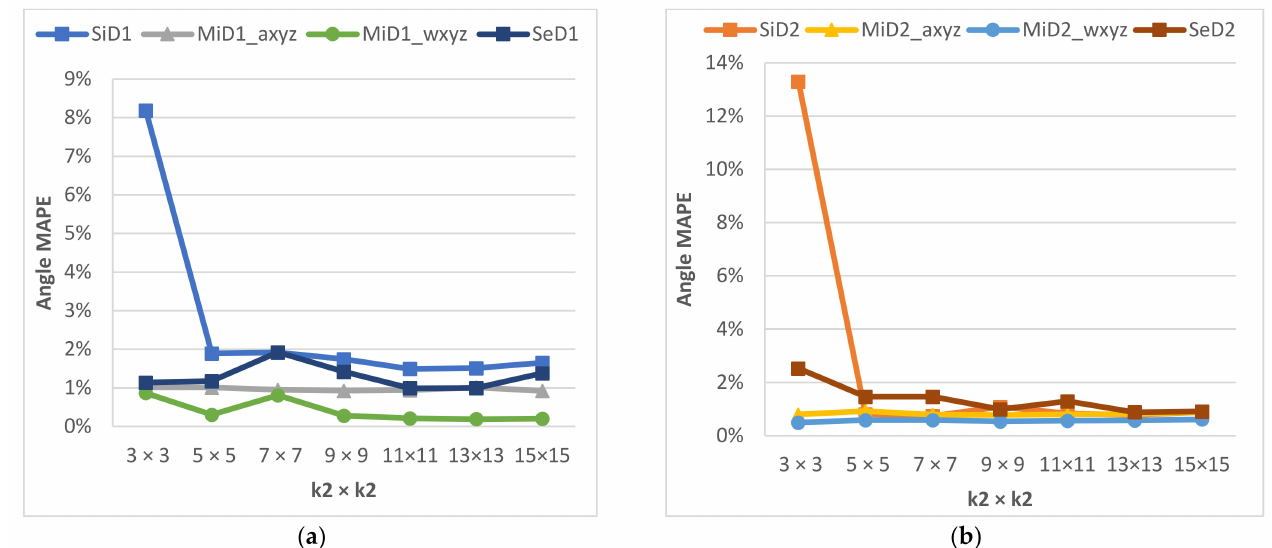
Figure 13. MAPE trends for steering wheel angle prediction of the architectures type 1 and type 2 with convolutional